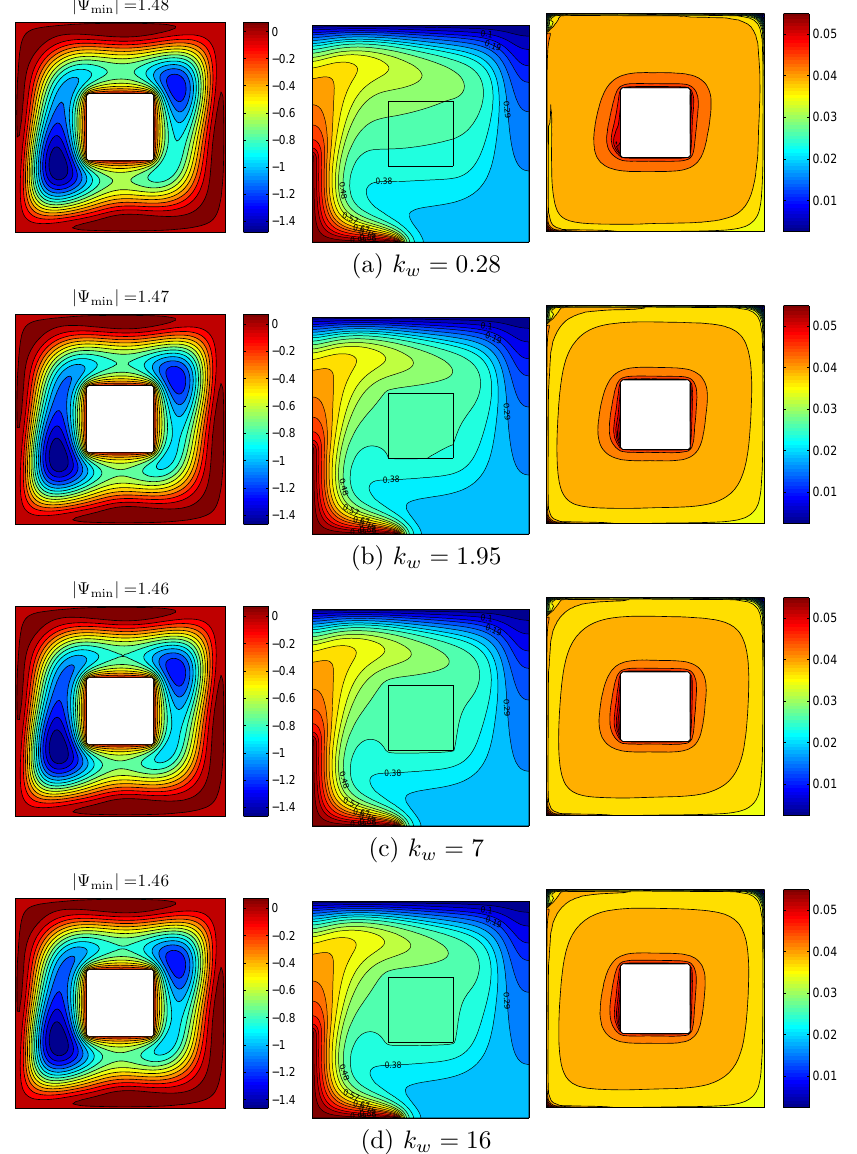
Figure 8. Variations of the streamlines ( left ), isotherms ( middle ), and nanoparticle distribution ( right ) evolution by thermal conductivity of the conjugate inner square ( k w ) for Ra = 10 5 , φ = 0.02 and D = 0.3. ( a ) k w = 0.28; ( b ) k w = 1.95; ( c ) k w = 7; ( d ) k w =